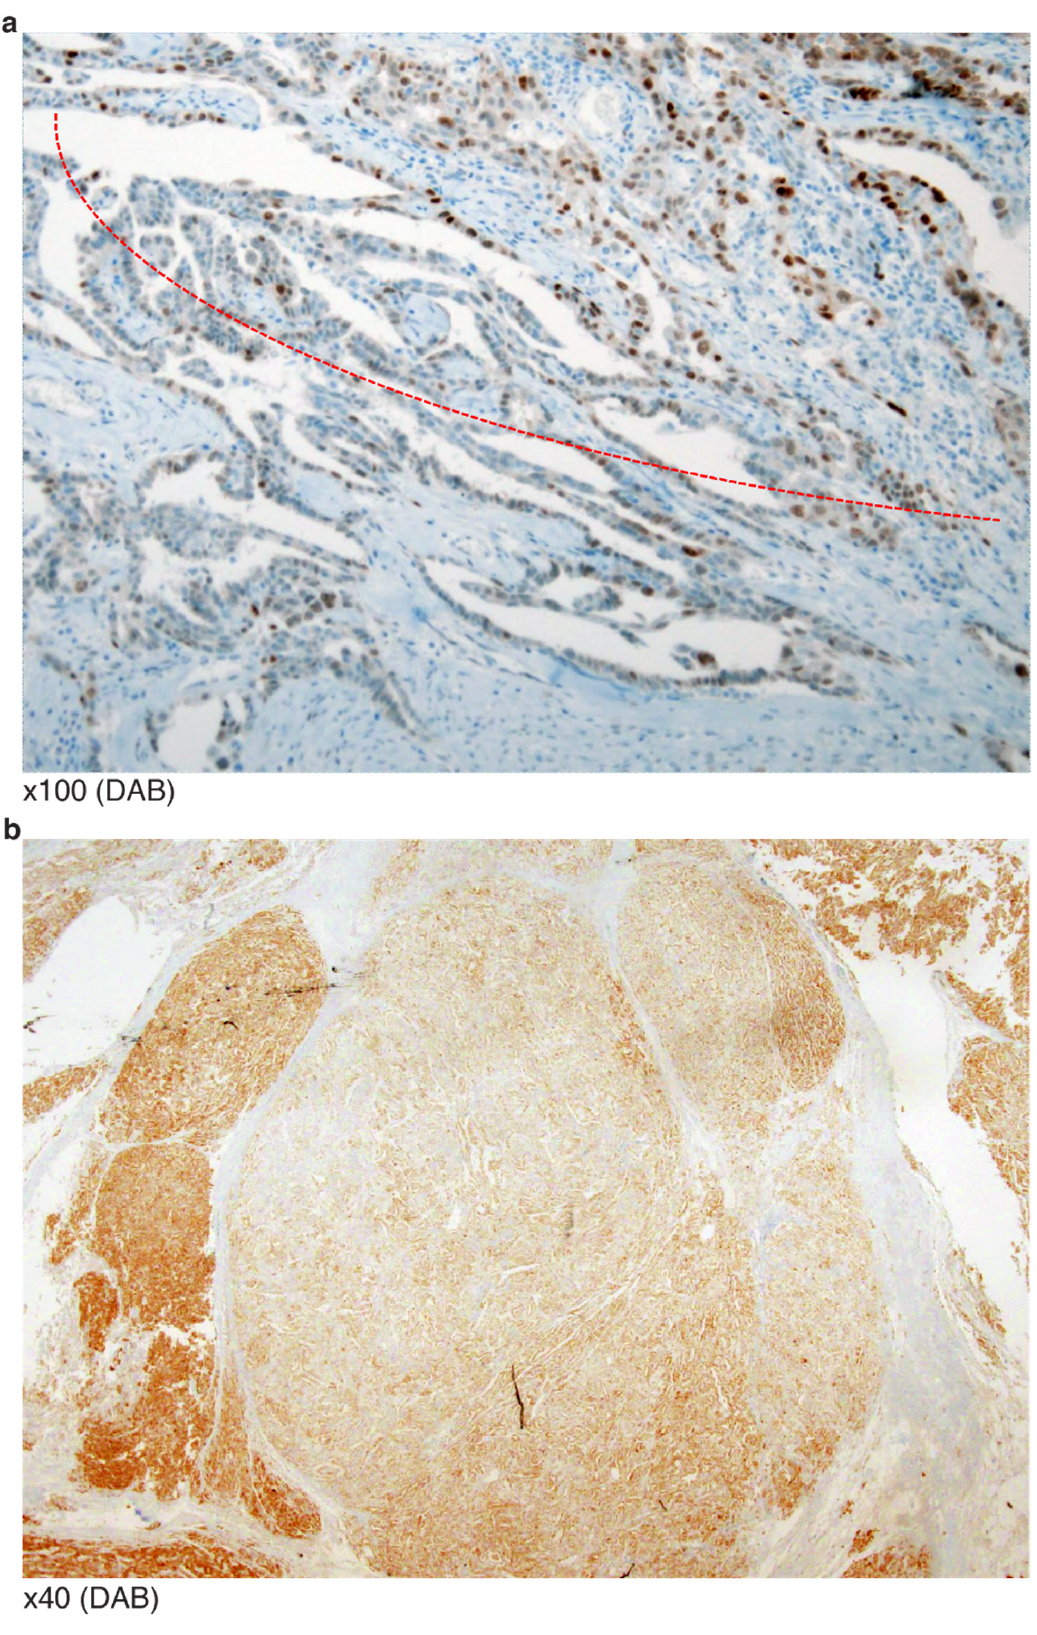
Figure 4. IHC mosaic patterns of p53: ( a ) Partly intense immunoreactivity in the field of papillary serous carcinoma; ( b ) zonal heterogeneity observed in an endometrioid carcinoma.